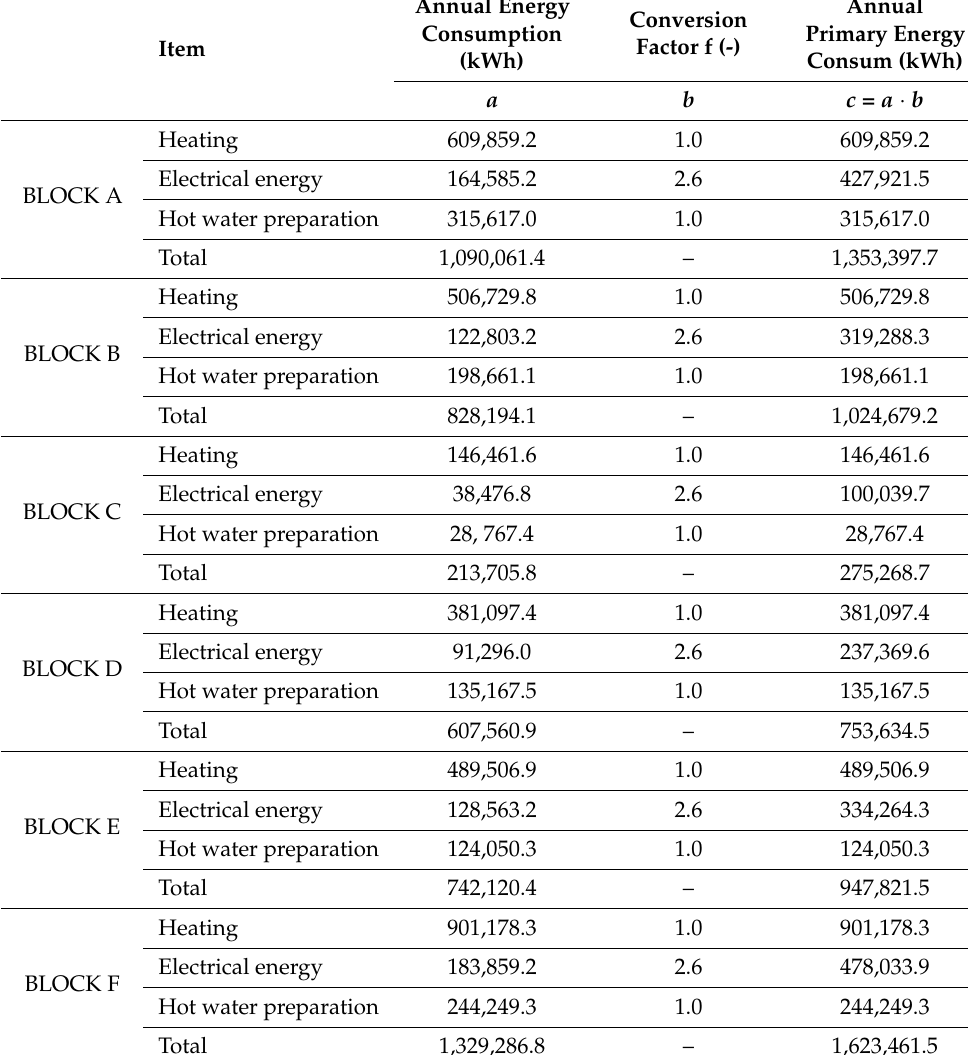
Table 13. Primary energy consumption values for the state before